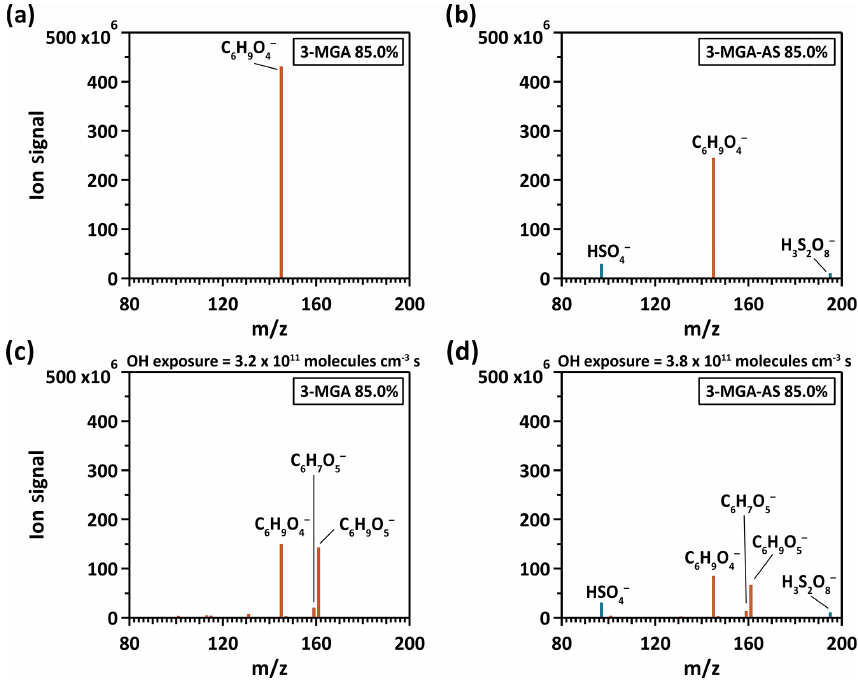
Figure 1. The particle mass spectrum of (a, c) 3-MGA and (b, d) 3-MGA–AS before (a, b) and after (c, d) heterogeneous OH oxidation at 85.0%RH, respectively. The brown color represents organic species and the blue color represents inorganic species.